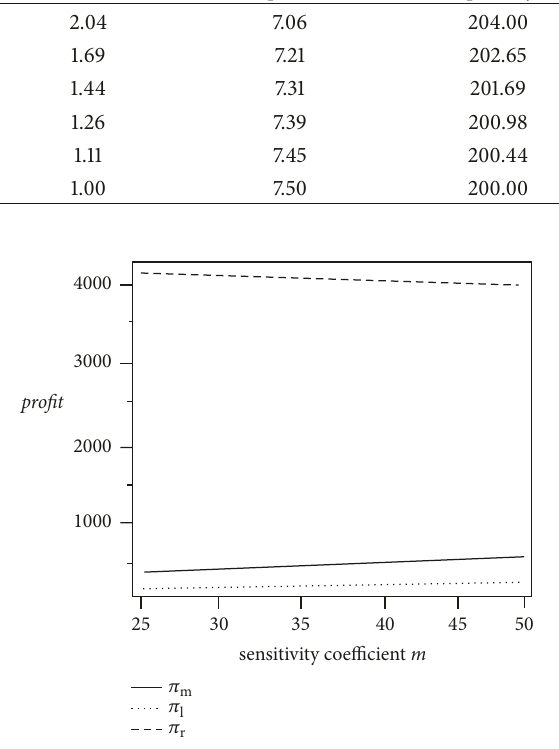
Figure 2: The effect of the logistics investment cost on the supply chain members’